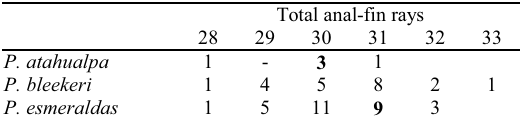
Table 25. Number of specimens of the species of Paracetopsis with cited number of total anal-fin rays. Bold indicates value for holotype when examined.